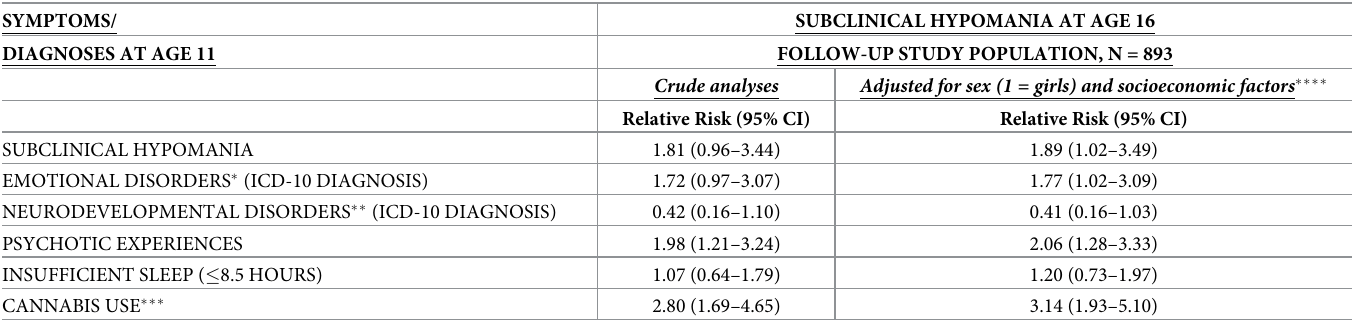
Table 5. Multivariate analysis–the association between symptoms/ diagnoses at age 11 and subclinical hypomania at age